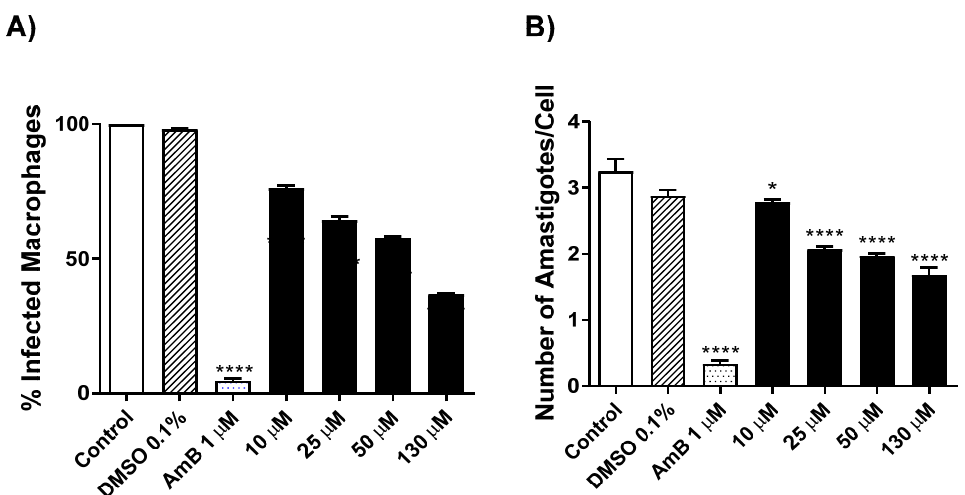
Figure 8. Effect of chalcone 4f on L. amazonensis -infected macrophages. L. amazonensis -infected macrophages were treated for 24 h with 10, 25, 50, and 130 µ M, and ( A ) the percentage of infected macrophages and ( B ) the number of amastigotes per macrophage were evaluated. Control (infected macrophage), vehicle (DMSO 0.1%) and AmB (1 µ M) were used as positive controls. The values represent the mean ± SEM of three independent experiments performed in triplicate. * Significant difference compared to control ( p ≤ 0.05), **** ( p ≤ 0.0001).